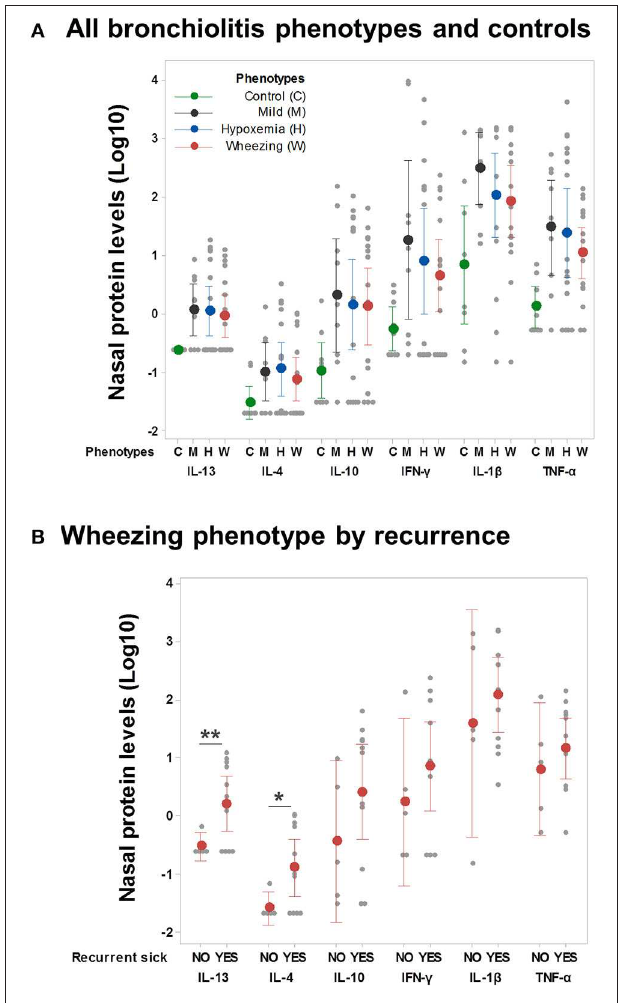
FIGURE 3 | Airway immune responses and phenotype-specific outcomes. (A) Nasal cytokine profiles (protein levels pg/ml, log-10 transformed) among controls and individuals in all clinical phenotypes ( n = 50). Ninety-five percent confidence intervals correspond to ANOVA and Dunn’s post-test adjusted values. (B) Nasal cytokine profiles in the wheezing phenotype only ( n = 16) according to the presence of recurrent respiratory sick visits after discharge. ** p < 0.01, * p <